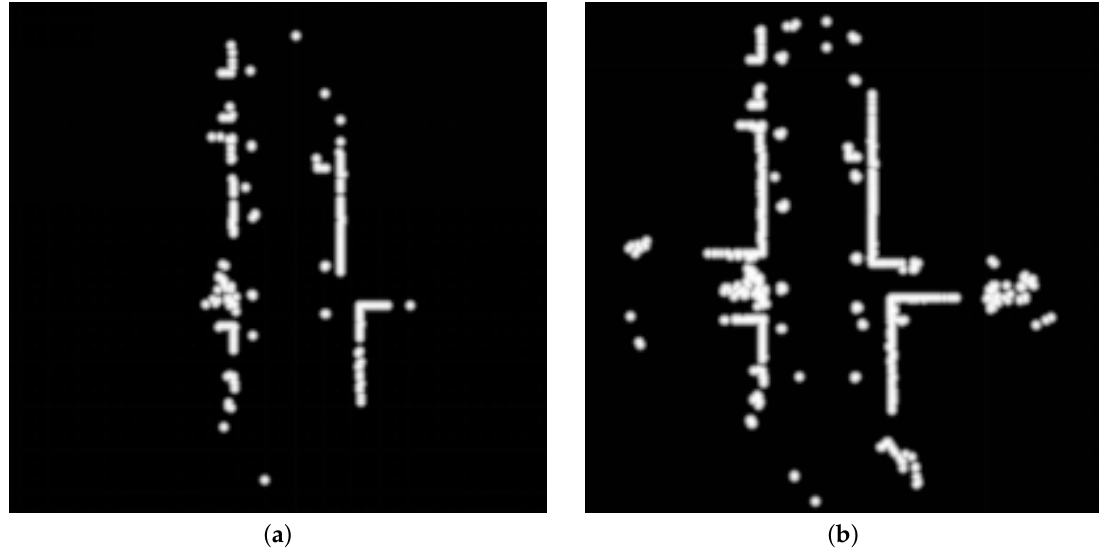
Figure 2. The comparative results of different rasterization methods. ( a ) Rasterized cost table from single scan. ( b ) Rasterized cost table from multiple scans.